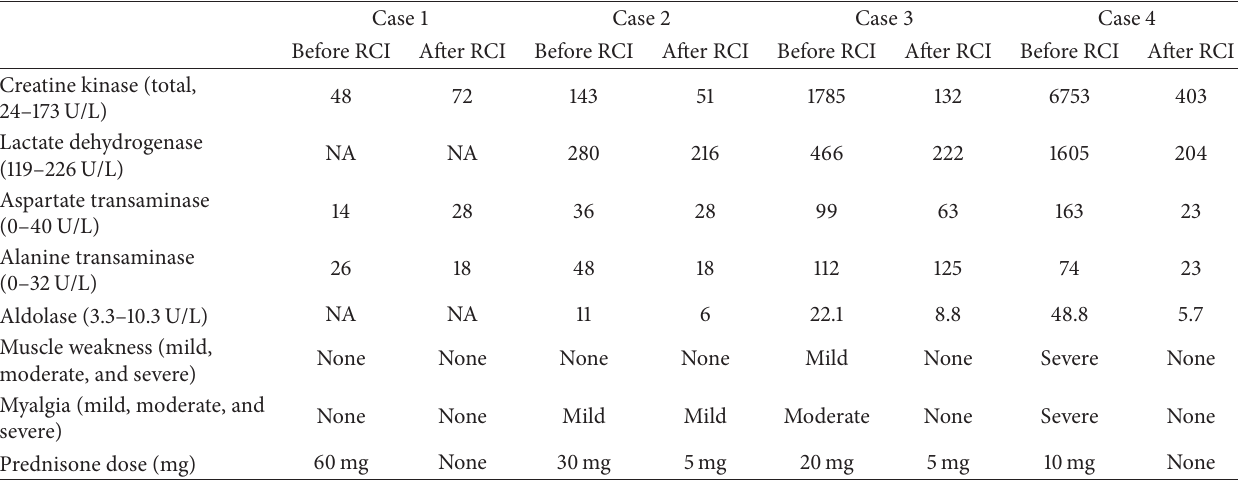
Table 2: Clinical laboratory values for each case before and after treatment with